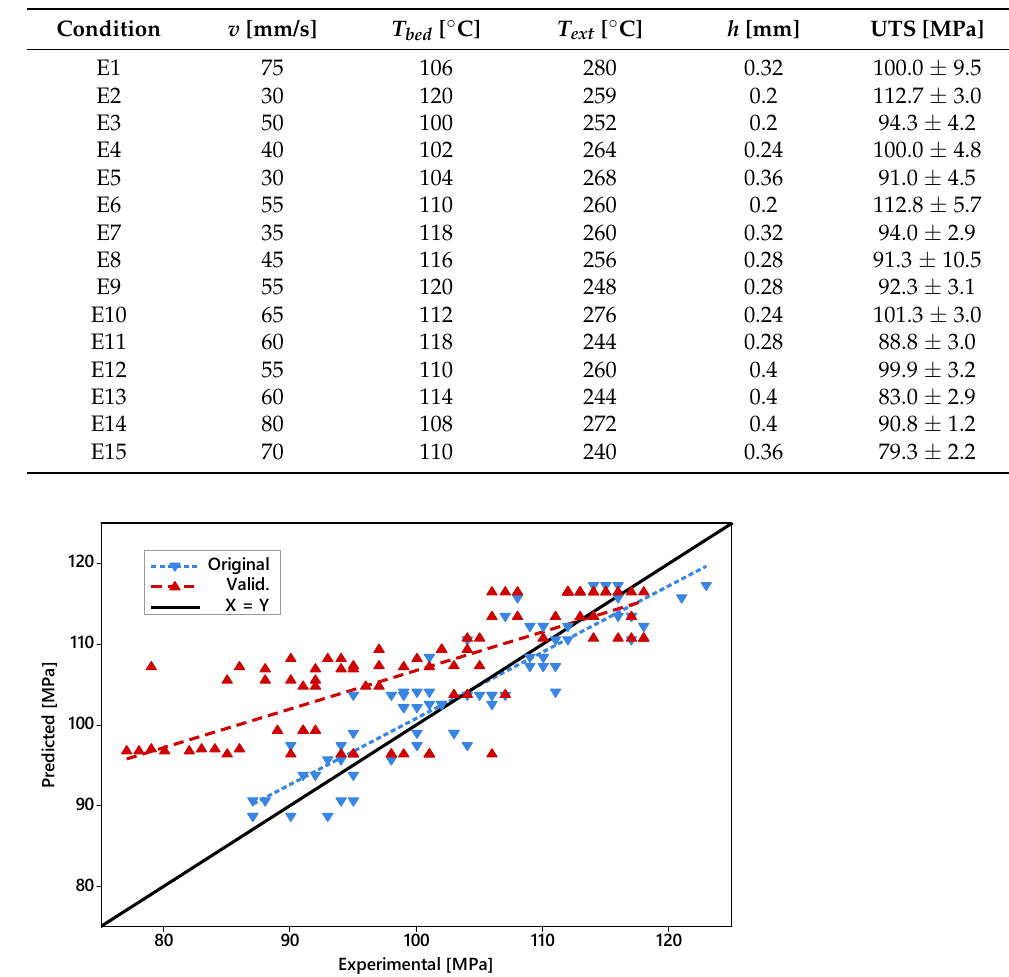
Table 5. Optimal parameter combination and predicted maximum UTS based on the DoE prediction model.